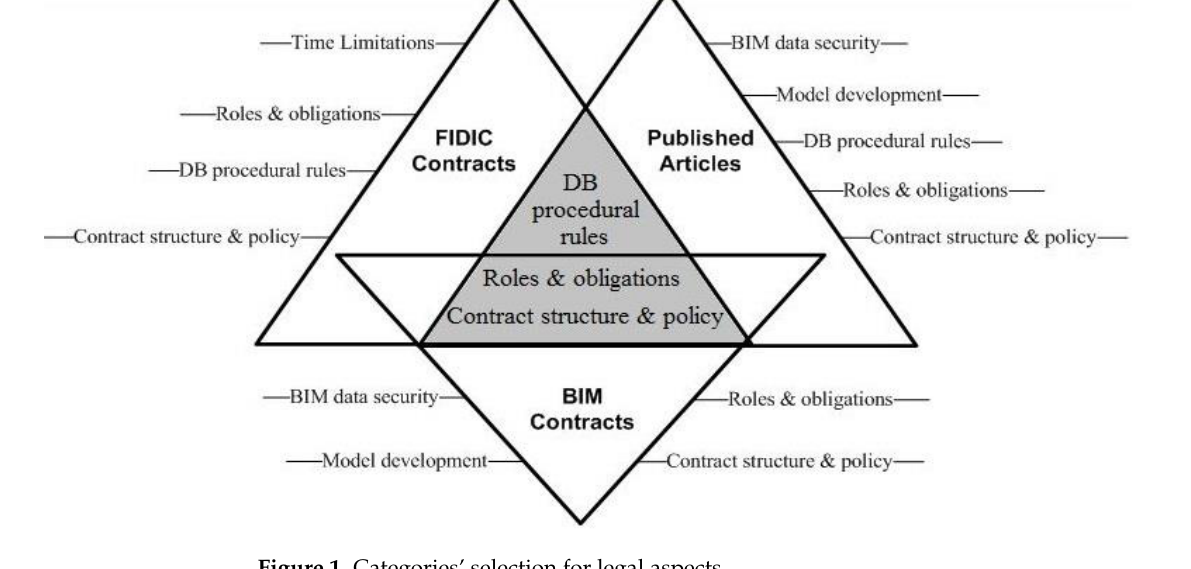
Figure 1. Categories ’ selection for legal aspects.